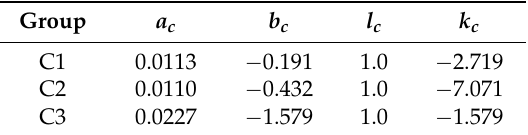
Table 7. The parameter of a c , b c , l c and k c used to calculate